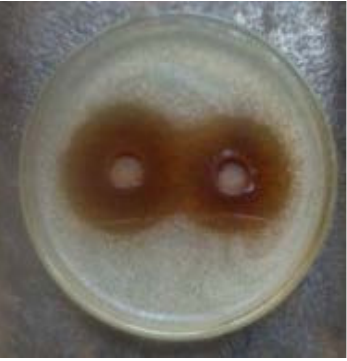
The clear zone on the left reffered to Peak I, and on the right reffered to Peak II Fig. 4. Fractionation pattern of active antimicrobial substance from P.plebeium ( PP) extract and their effect against MRSA, B39